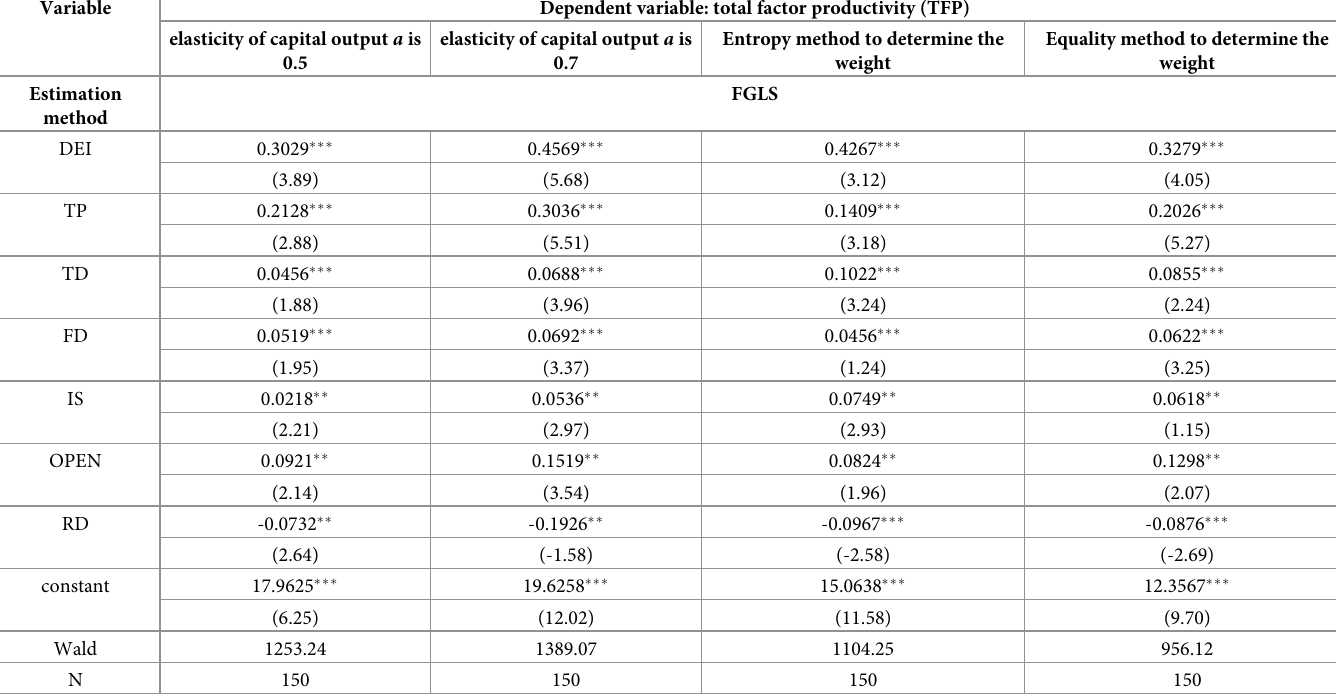
Table 11. Robustness test results. Variable Dependent variable: total factor productivity (TFP) elasticity of capital output a is